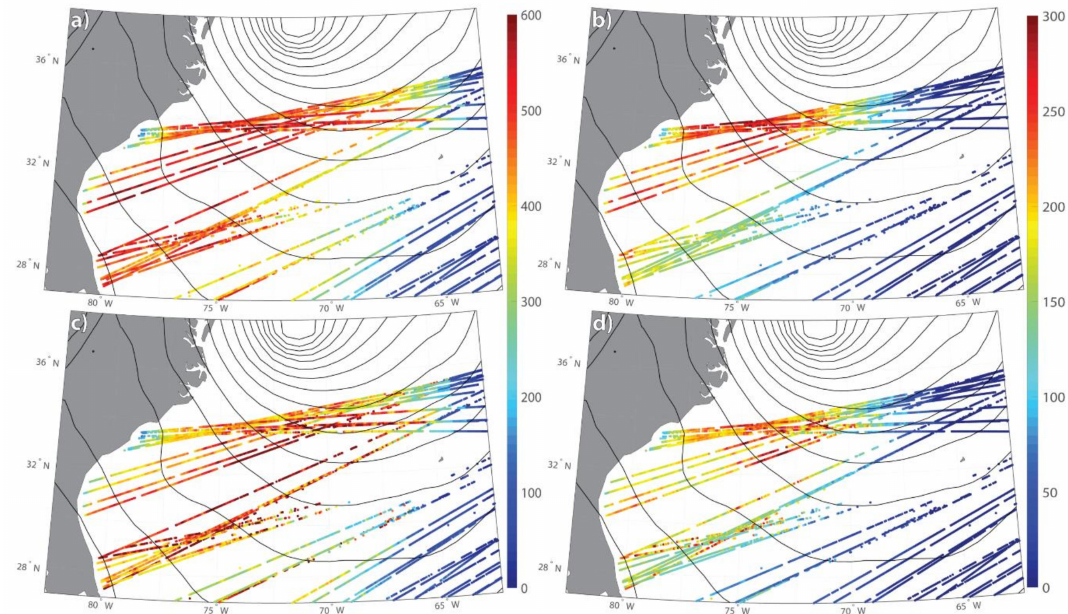
Figure 4. CYGNSS Flux Observations of an extratropical cyclone (ETC) on 4 January 2018. Contours of sea level pressure [black lines] at 1500 UTC with CYGNSS observations spanning ± 3 hours from this period. ( a ) LHF with FDS winds, ( b ) SHF with FDS winds; ( c ) LHF with YSLF winds; ( d ) SHF with YSLF